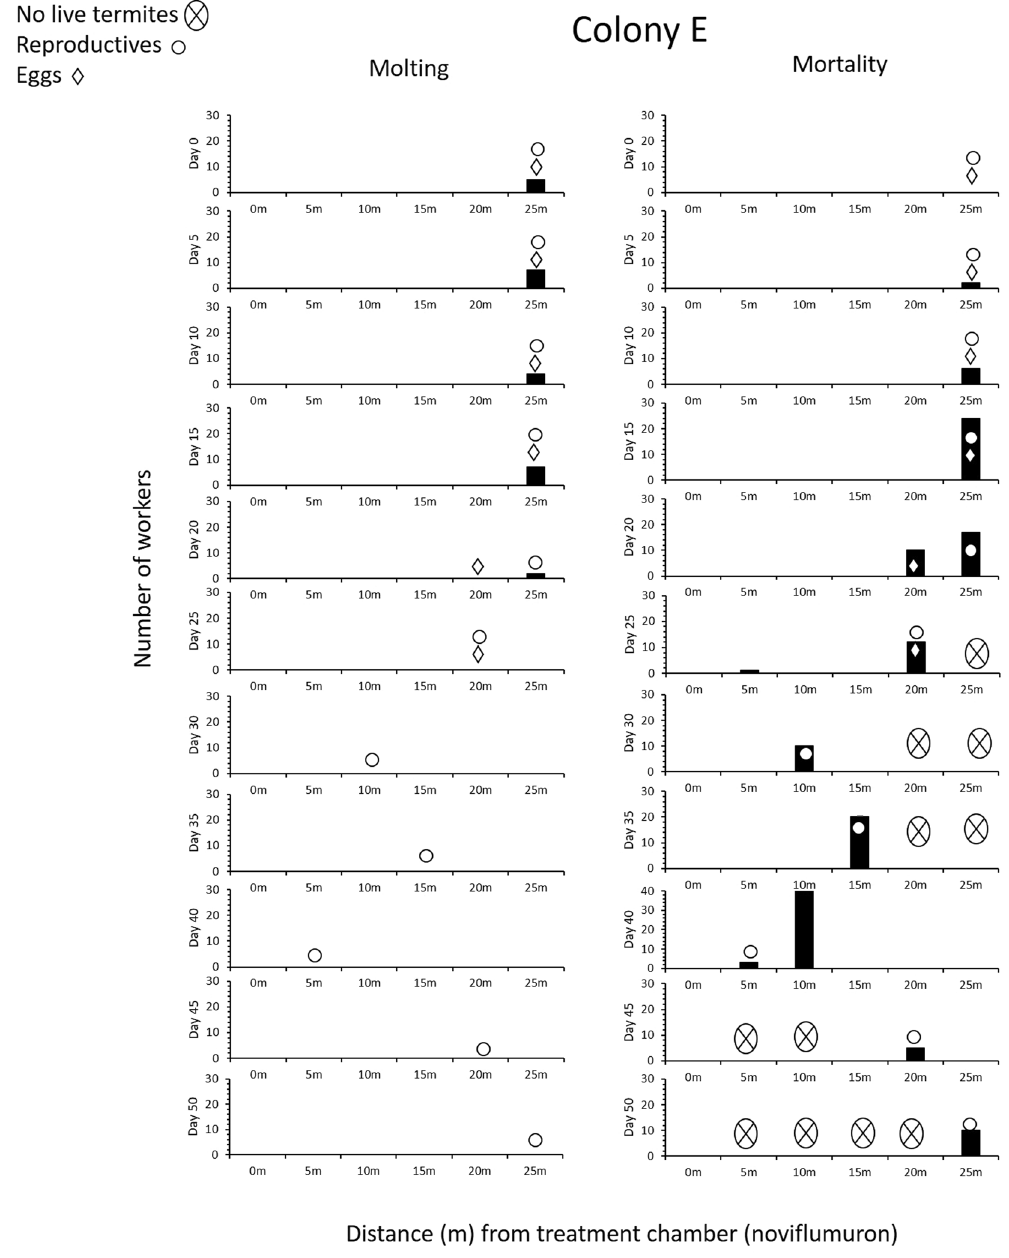
Figure 3. Number of worker molting (left) and worker mortality (right) in a 6 yr old juvenile colony (E) for noviflumuron